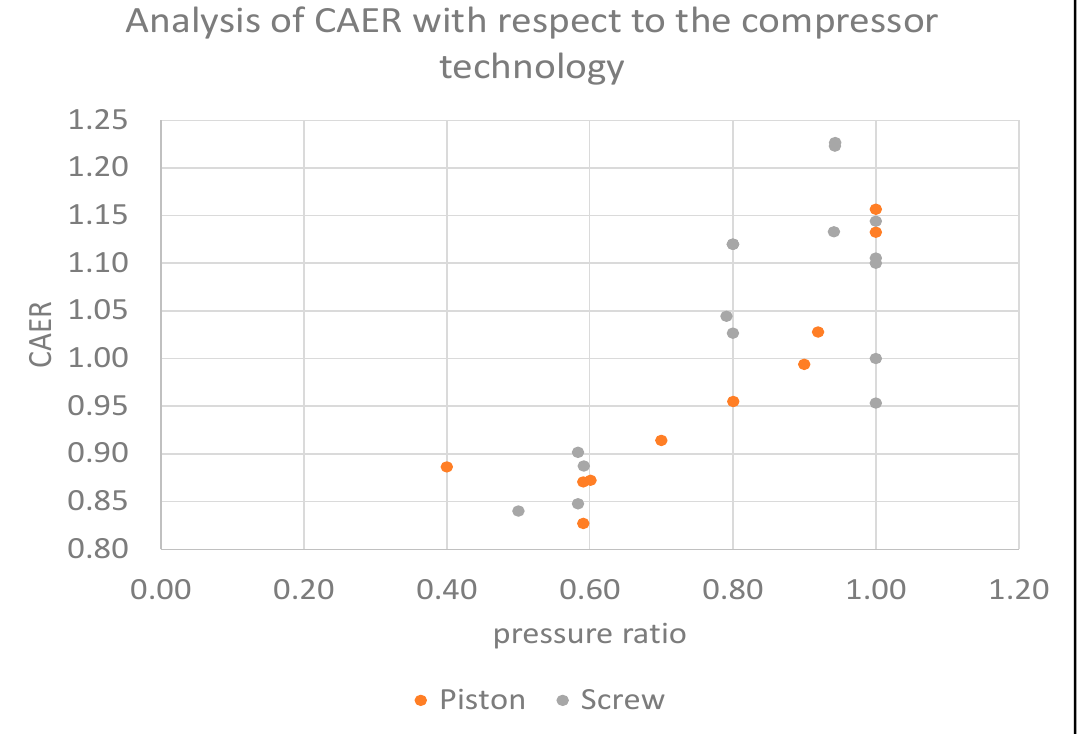
Figure 6. Comparison of different CAER in relation to pressure level.